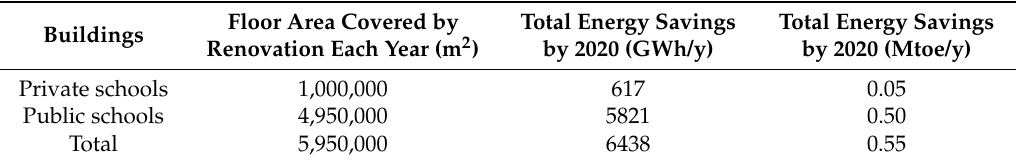
Table 1. Consumption reduction potential by 2020 from complete renovation of schools starting from